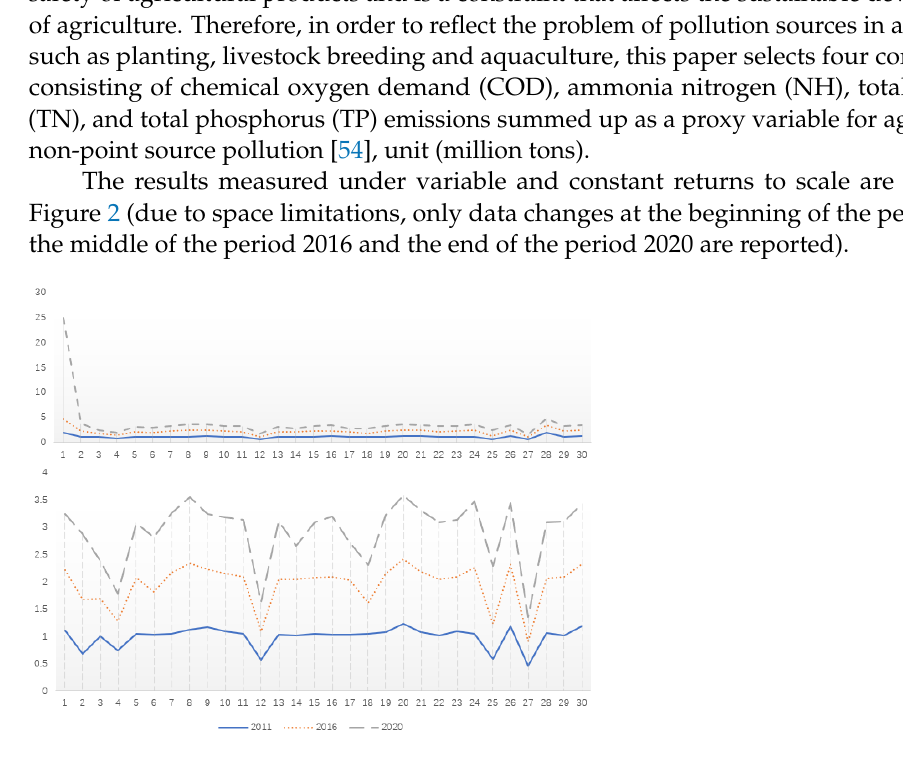
Figure 2. Schematic diagram of changes in AEE levels ( top : variable returns to scale; bottom : constant returns to scale). Note: Horizontal axes 1–30 denote the 30 Chinese provinces of Beijing, Tianjin,